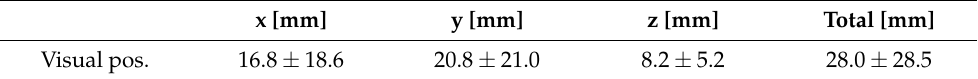
standard deviation]. ±